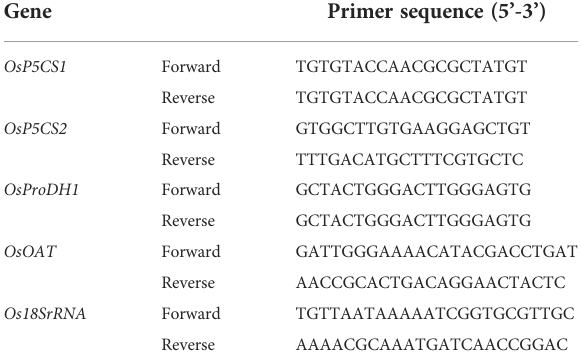
TABLE 1 List of primers used for real-time